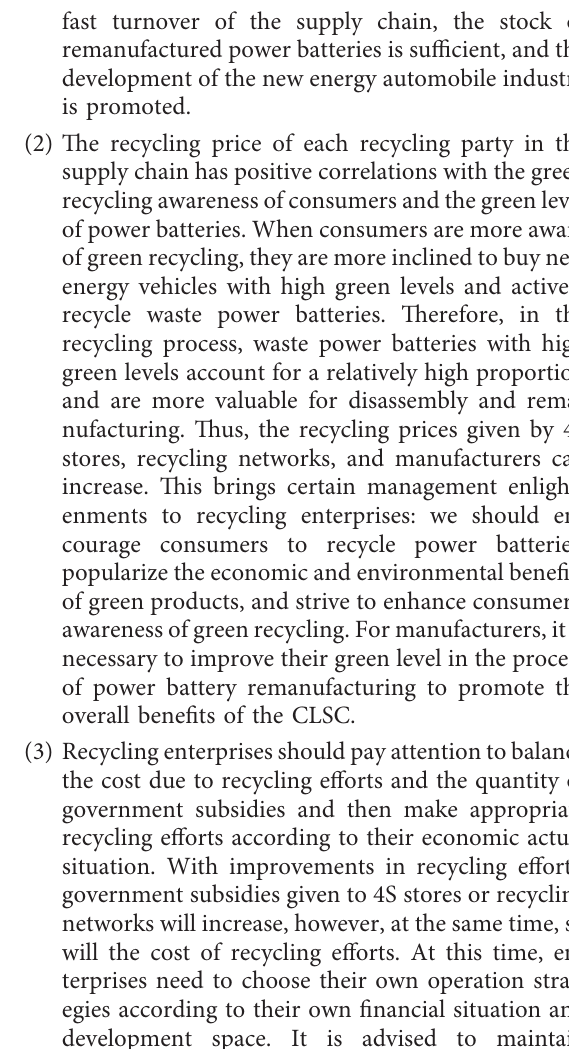
and p ; (c) the influence of recycling r n and v on the profit of recycling n r